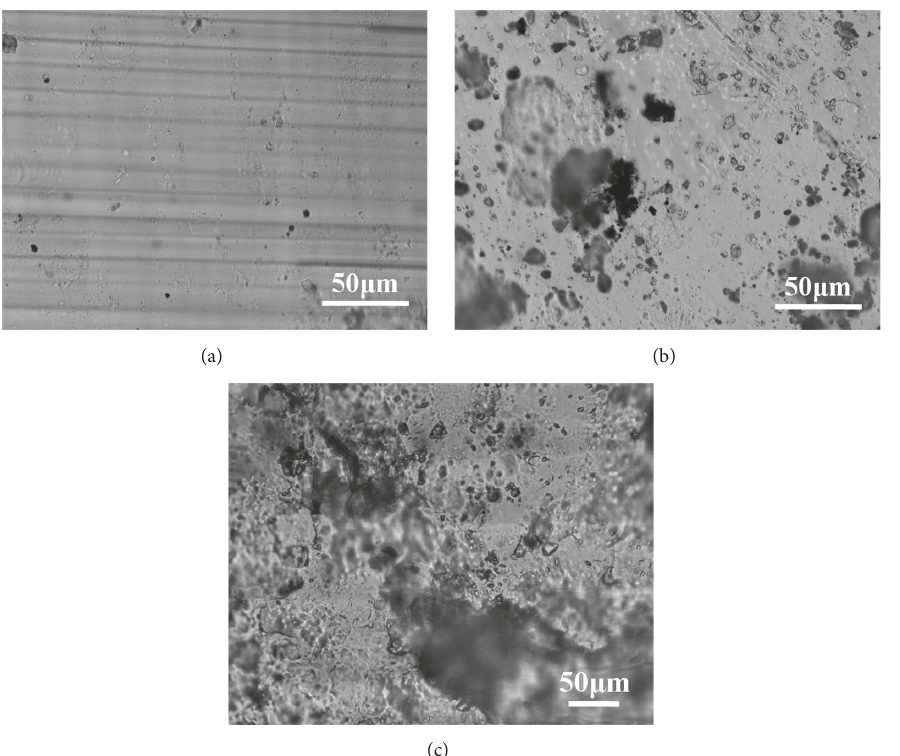
Figure 4: Micrographs of the surfaces ( × 50) of the unstressed specimens: (a) unconditioned specimen; (b) SWD0 after 60WD cycles; and (c) WWD0 after 180WD cycles.